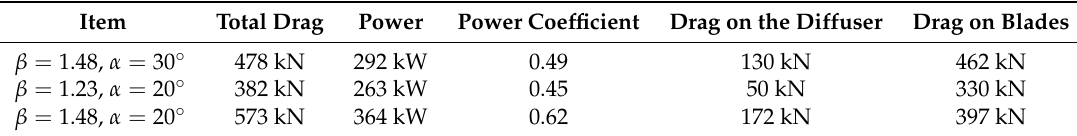
Table 1. Efficiency analysis of the diffusers with a plate cross-section.